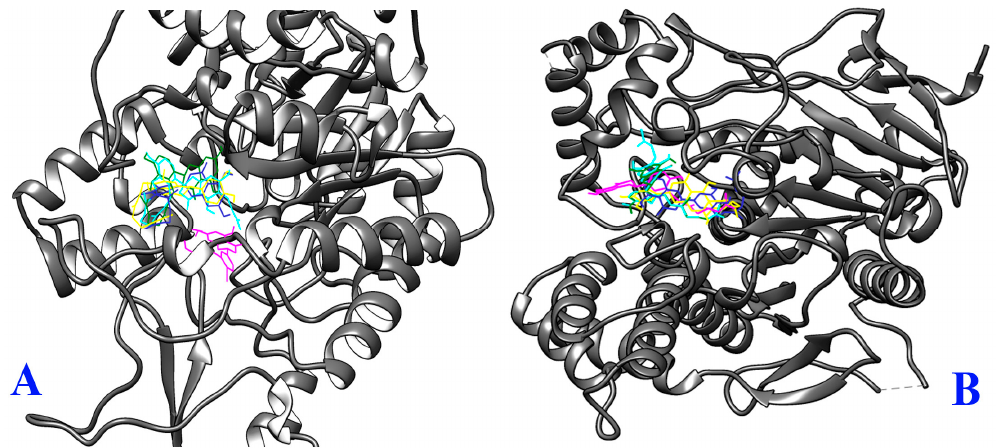
Figure 5. Binding orientations of Okinawa propolis (OP) compounds within α -glucosidase (Protein Data Bank identifier (PDB ID): 3A4A) and acetylcholinesterase (PDB ID: 4EY7) protein receptors. ( A ) Binding orientation within 3A4A (nymphaeol-A (NA) = yellow; nymphaeol-B (NB) = green; nymphaeol-C (NC) = cyan; isonymphaeol-B (INB) = blue; 3 ′ -geranyl-naringenin (GN) = magenta), and ( B ) binding orientation within 4EY7 (NA = yellow; NB = green; NC = cyan; INB = blue; GN = magenta).